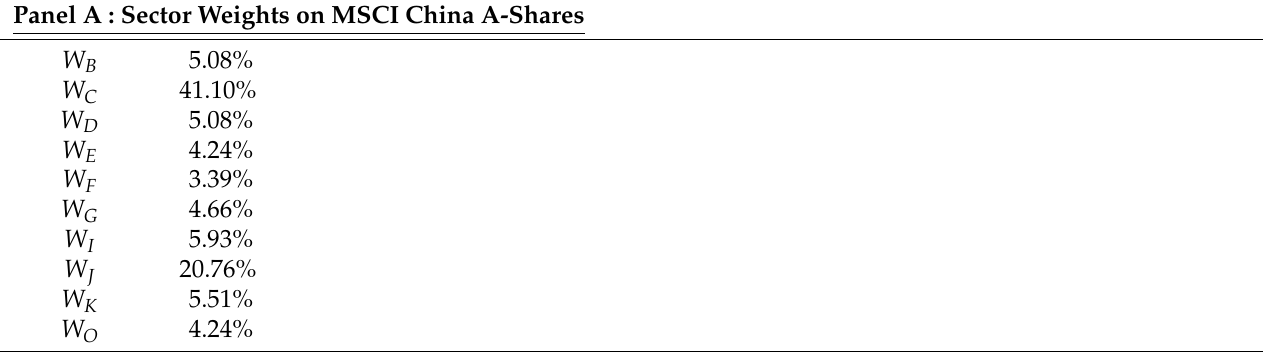
Table 11. Forecasting MCASI’s return with the returns of the sector